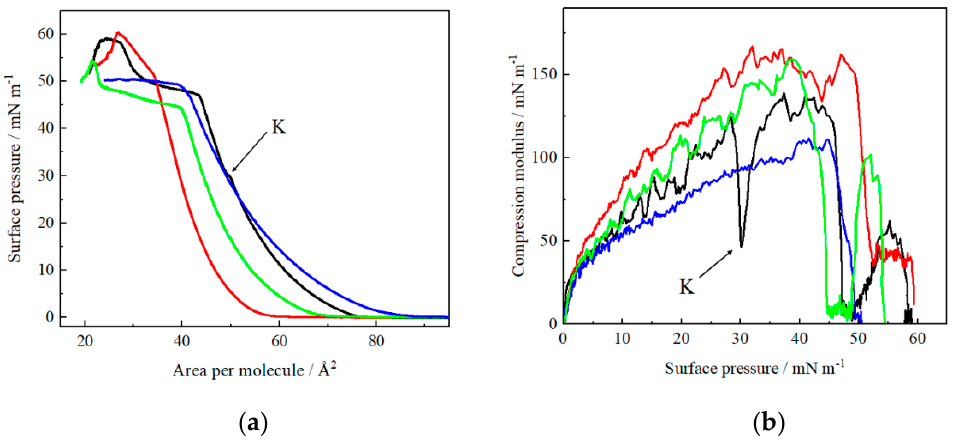
Figure 2. Surface pressure-area per molecule ( π -A) isotherms of ( a ) DOPC:Chol:SM 1:1:2 (green), DOPC:Chol:SM 1:2:1 (red), DOPC:Chol:SM 2:1:1 (blue) and DOPC:Chol:SM 1:1:1 (black) monolayers formed on PBS buffer and ( b ) compression modulus vs. surface pressure plot. (T = 21 ± 1 °C).